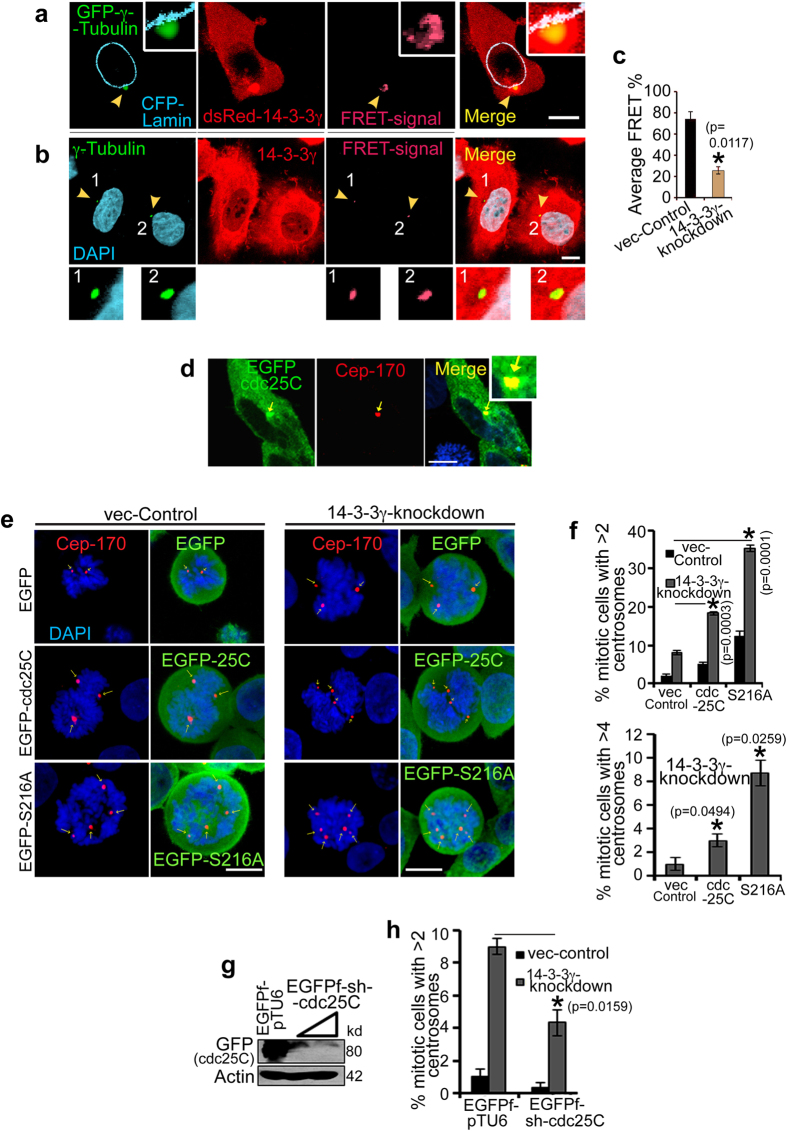
Cdc25C activity stimulates centrosome over-duplication in 14-3-3γ-knockdown cells.(a–c) HCT116 cells were transfected with CFP-Lamin-A (cyan), GFP-γ-Tubulin (donor) and dsRed-14-3-3γ (acceptor) (a) or stained with antibodies to γ-Tubulin (green) and 14-3-3γ (red) (b) and counter-stained with DAPI (blue) followed by sensitized emission FRET analysis. The FRET images are shown in the third panel from the left, while the fourth image from the left shows the merged image as indicated. The smaller panels show a magnified image of the boxed region. (c) A comparison of FRET signal intensities obtained from antibody based FRET was performed in 14-3-3γ-knockdown and control line. The graph shows the mean and standard deviation for percentage FRET efficiency from ten different cells. p values indicated were obtained using a student’s t-test (2 sample unequal variance) and the asterisk indicates p < 0.05. (d) Co-localization of cdc25C at centrosome is determined by transfecting HCT116 cells with EGFP-cdc25C (green) and staining with anti Cep-170 (red) antibody. (e–g) 14-3-3γ-knockdown cells were transfected with the vector control (EGFP), EGFP-cdc25C or EGFP-S216A and stained with antibodies to Cep-170 (red) (e). (f,g) Centrosome number was determined and the mean and standard error from three different experiments is plotted (h) 14-3-3γ-knockdown and control cells were co-transfected with GFP-cdc25C and increasing concentration of EGFPf-sh-cdc25C. Western blot is showing the reduction in GFP-cdc25C upon expression of sh-cdc25C. (i) Vector control and 14-3-3γ knockdown cells were transfected with the vector control (EGFPf-pTU6) or EGFP-f-shcdc25C. The transfected cells were stained with antibodies to Cep170 and centrosome number was determined in a 100 transfected cells (identified by GFP expression) in three independent experiments. In all cases p values were obtained using a student’s t-test. Scale bars are 10 μm unless mentioned. All the Western blots were run under the same experimental conditions and the full length blots are in Supplementary Fig. 6.